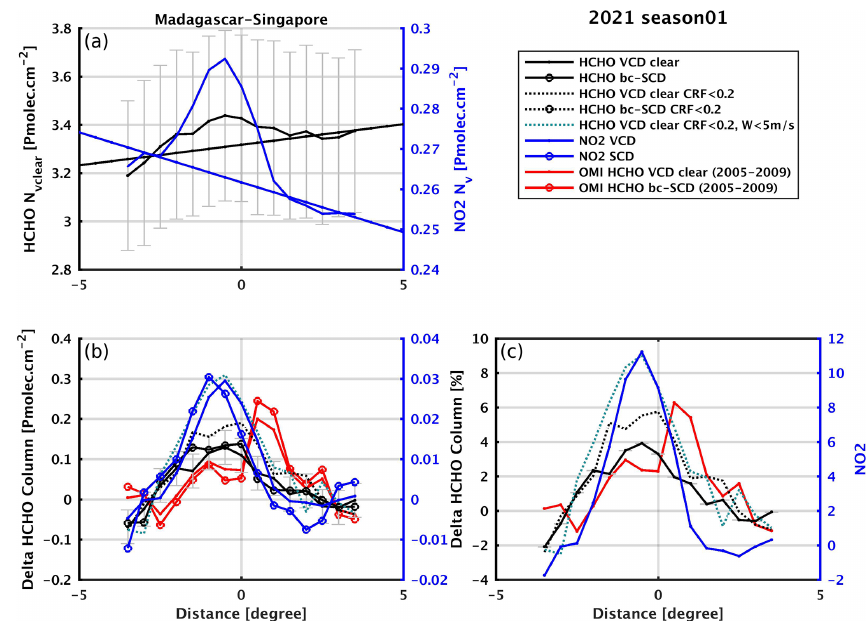
Figure 20. Same as Fig. 19 for the second selected line between Madagascar and